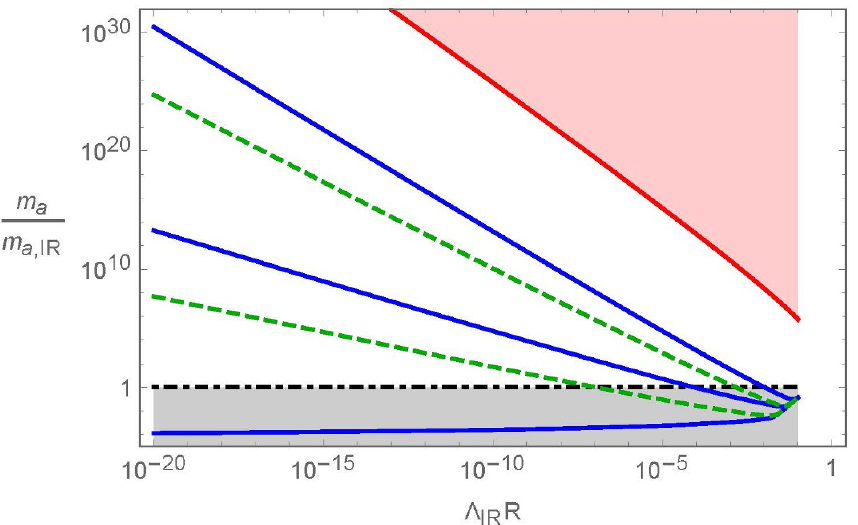
Figure 2 . The axion mass ratio for the pure YM case as a function of (cid:3) IR R for various contours of (cid:15) = (0 : 3 ; 0 : 25 ; 0 : 2) (top to bottom). The solid blue lines are the exact numerical integration results using (2.8) with no higher dimension terms ( c 6 = 0). The green dashed line represents the addition of the higher dimension term (2.11) with c 6 = 0 : 5 and (cid:15) = 0 : 52(0 : 47) for the upper (lower) line. The red line represents the maximum enhancement using m a; 5 that would occur at the 5D strong-coupling